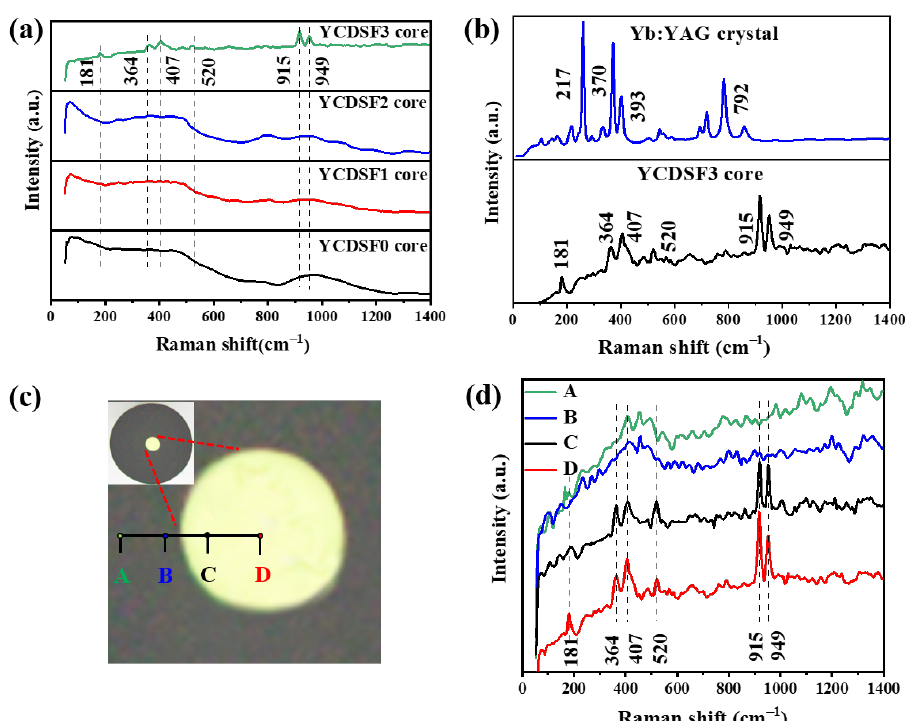
Figure 3. ( a ) Raman spectra of the core layer of the YCDSF0 and YCDSF heat-treated at different temperatures. ( b ) Raman spectra of Yb:YAG crystal and core layer of the YCDSF3. ( c ) The enlarged image of the YCDSF3 cross-section. A, B, C, and D are the measured positions of Raman spectra on the fiber. Inset is the whole image of the YCDSF3 cross-section. ( d ) Raman spectra of the YCDSF3 at different positions.